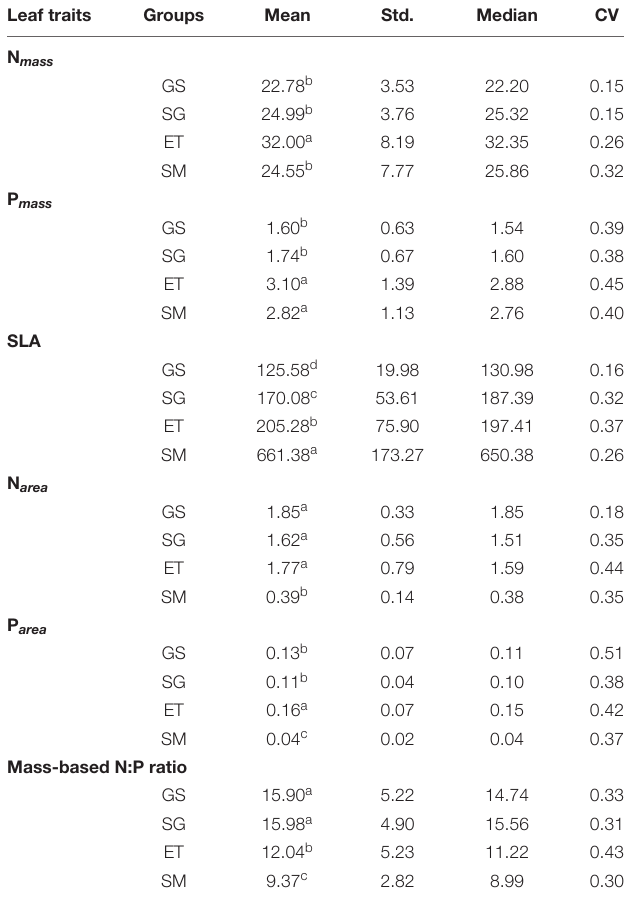
Number of observations (Num.), arithmetic mean values (Mean) and standard deviations (Std.), median values, and CV were listed. The coefficients of variation (CV) were calculated by dividing Std. by Mean, and represented the variability in leaf nutrient elements within plant group. Different letters that marked on Mean indicated significant differences in mean leaf N mass , P mass , SLA, N area , P area , and N:P ratio between different plant groups, respectively (p < 0.05). Number of observations (n): ET, 269; SM, 30; GS, 31, SG,